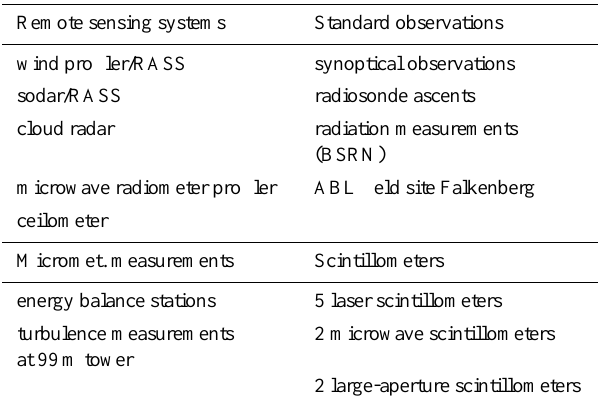
Table 2. Operated measurement systems during LITFASS-2009. Remote sensing